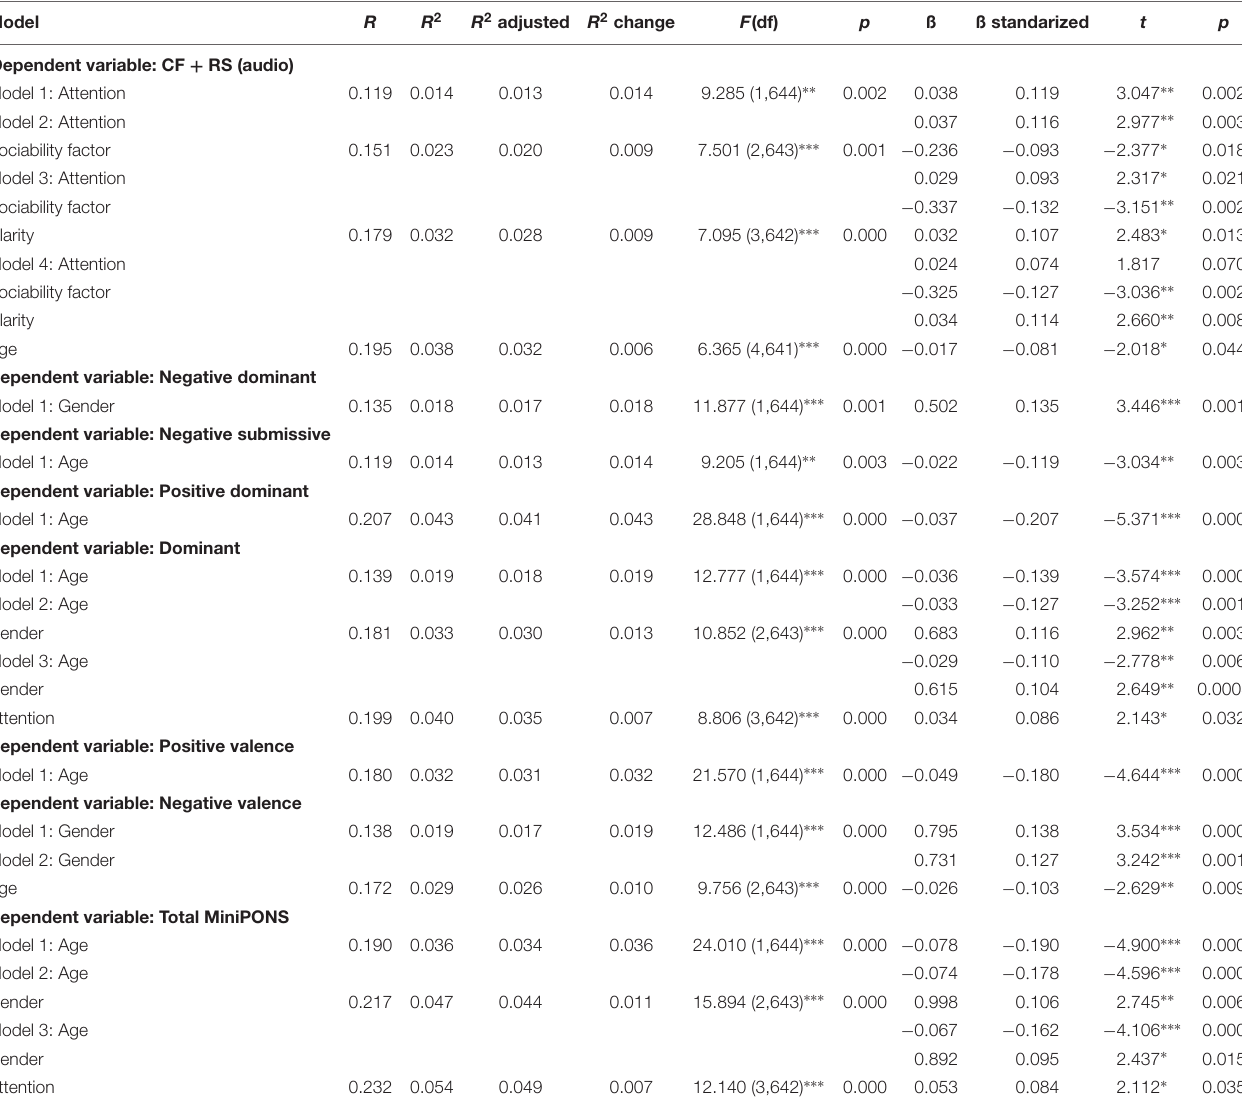
TABLE 6 | Stepwise multiple regression